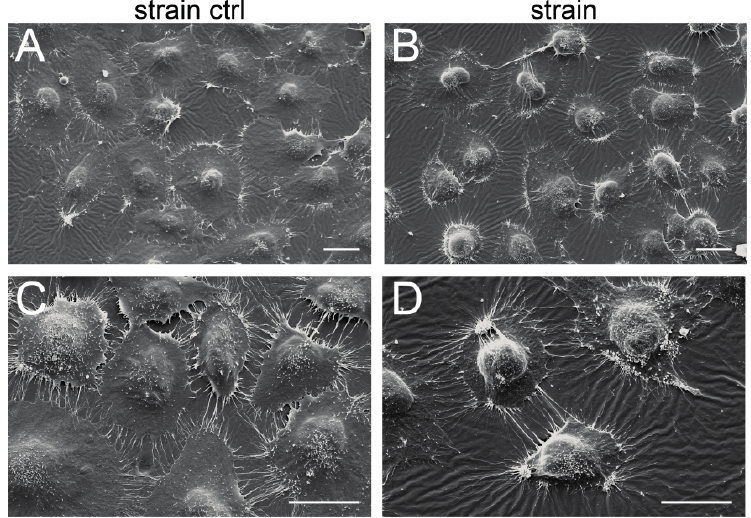
Figure 7. Morphological changes in stretched chondrocytes. C-28/I2 cells were stretched (8%) for 12 h using cyclic square waveforms at 0.5 Hz and immediately fixed on the silicone membrane. Shown are representative scanning electron micrographs of unstrained cells (strain ctrl: A , C ) and stretched cells (strain: B , D ). Scale bars represent 25 μ m. n =